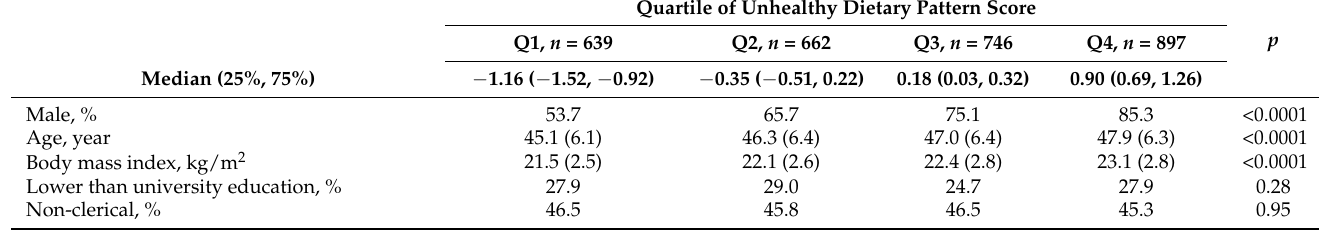
Table 3. Baseline characteristics of the participants according to the quartiles of the Unhealthy Dietary Pattern for the Aichi Workers’ Cohort,